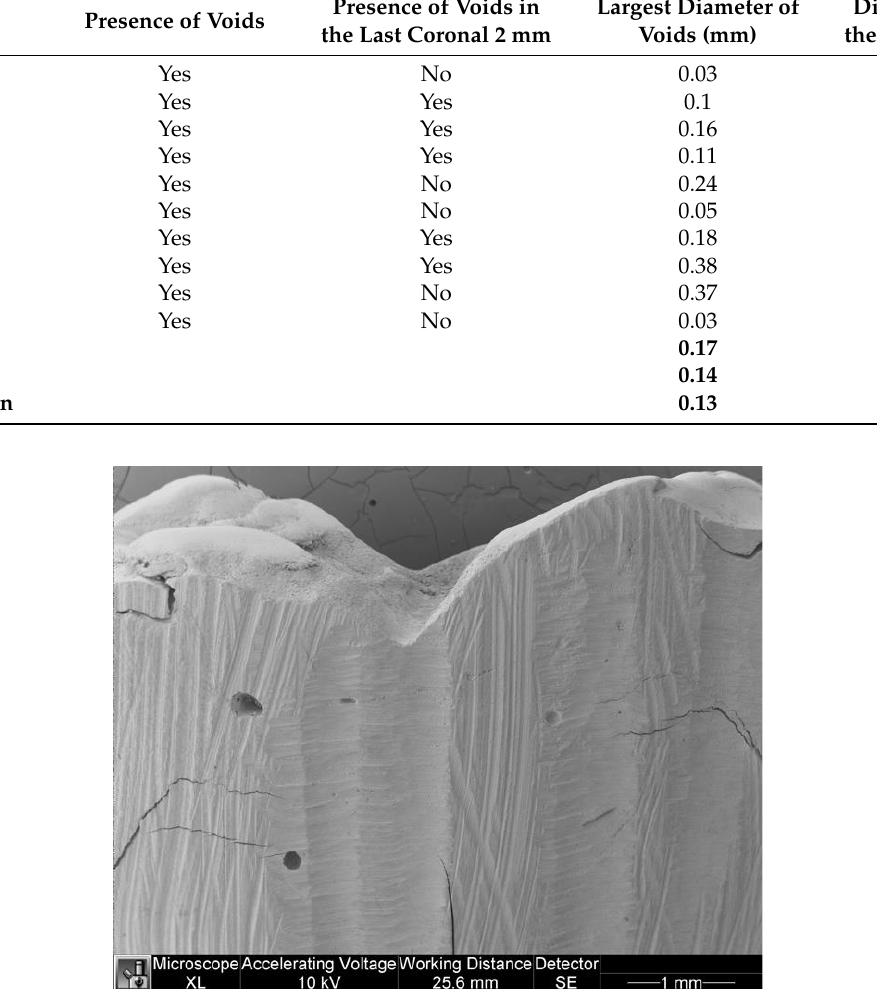
Figure 11. Voids in a specimen of the study group.